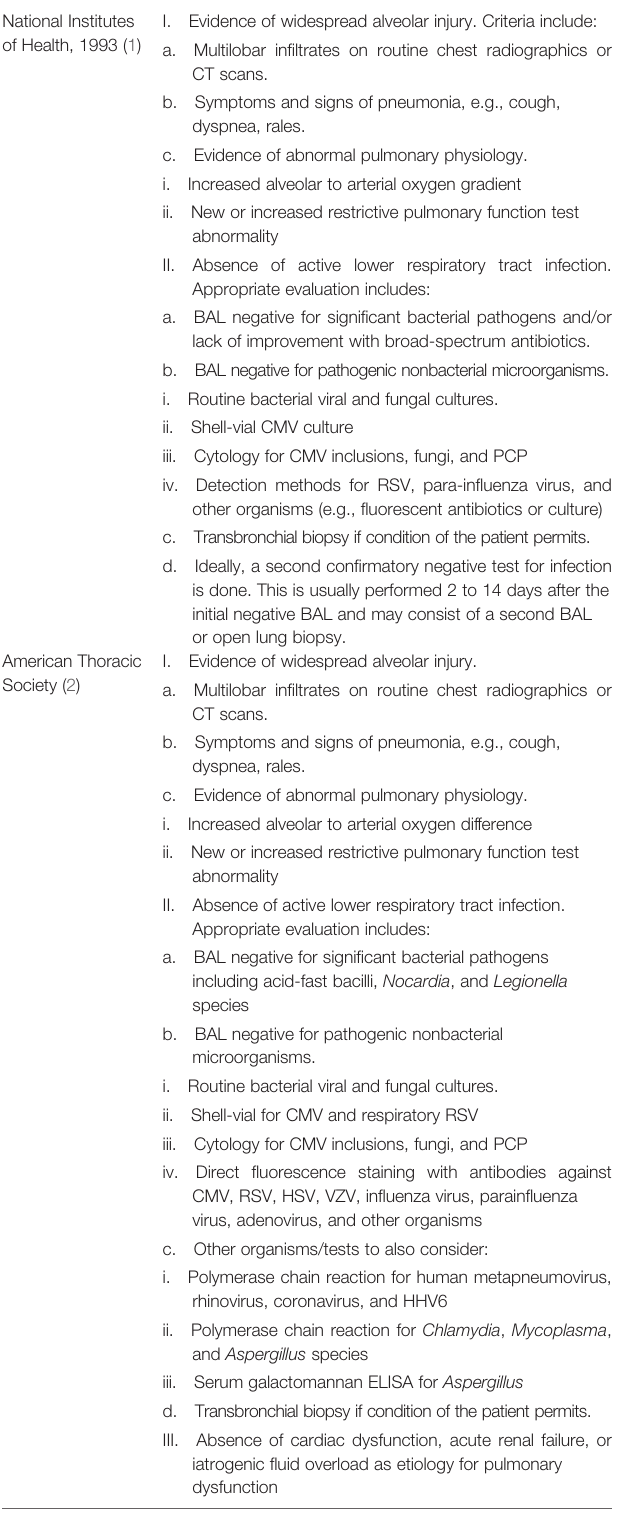
TABLE 1 | De fi nitions of pulmonary